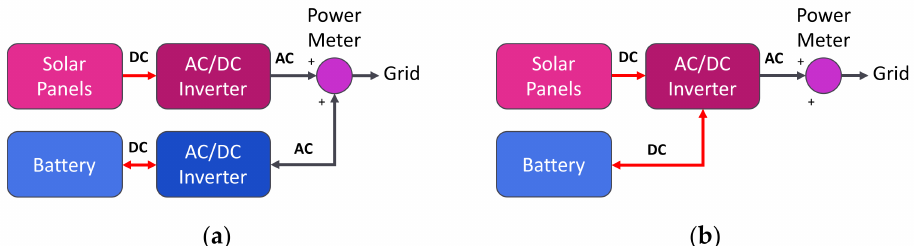
Figure 4. Solar plus battery installation types. ( a ) shows the AC-Coupled System, and ( b ) shows DC-Coupled System. In both cases, a mandatory metering system is located just before the grid and measures integrated